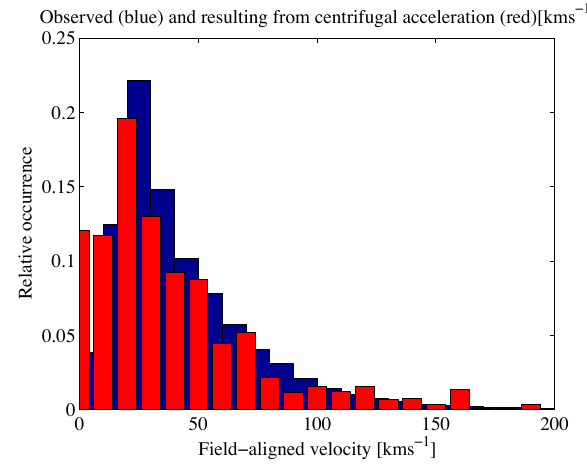
Fig. 8. Distribution of the observed parallel velocities (blue bars) and the parallel velocity resulting from the cumulative centrifugal acceleration observed at all altitudes below each observation point (red bars) [ kms − 1 ] , The initial velocity at the lowest altitude of the data set for each orbit has been added to make the two distributions comparable. The y-axis shows the relative occurrence. The red bars are shifted half a bin towards lower values to increase readability.